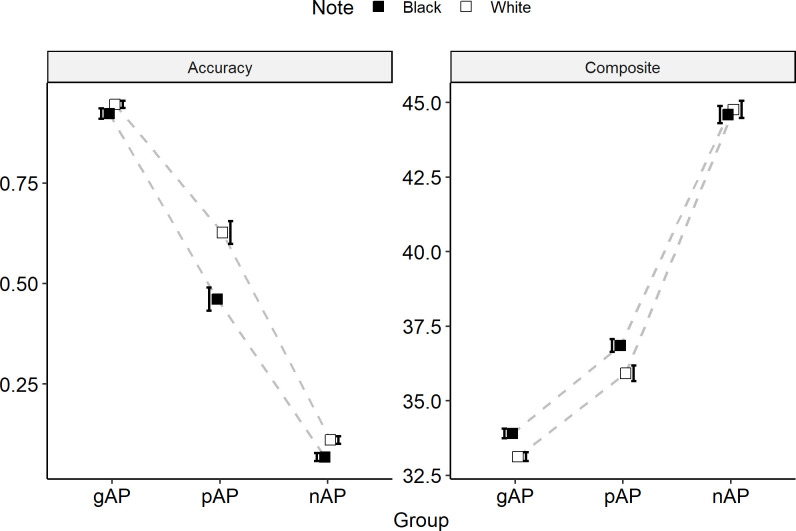
Interaction plots of from the 2 (note: White, black) x 3 (group: Genuine-AP, pseudo-AP, non-AP) ANOVAs for both mean accuracy and the composite measure. Error bars represent ± 1 standard error of the mean. Pseudo-AP subjects show the same performance bias known to be characteristic of genuine-AP level performers.